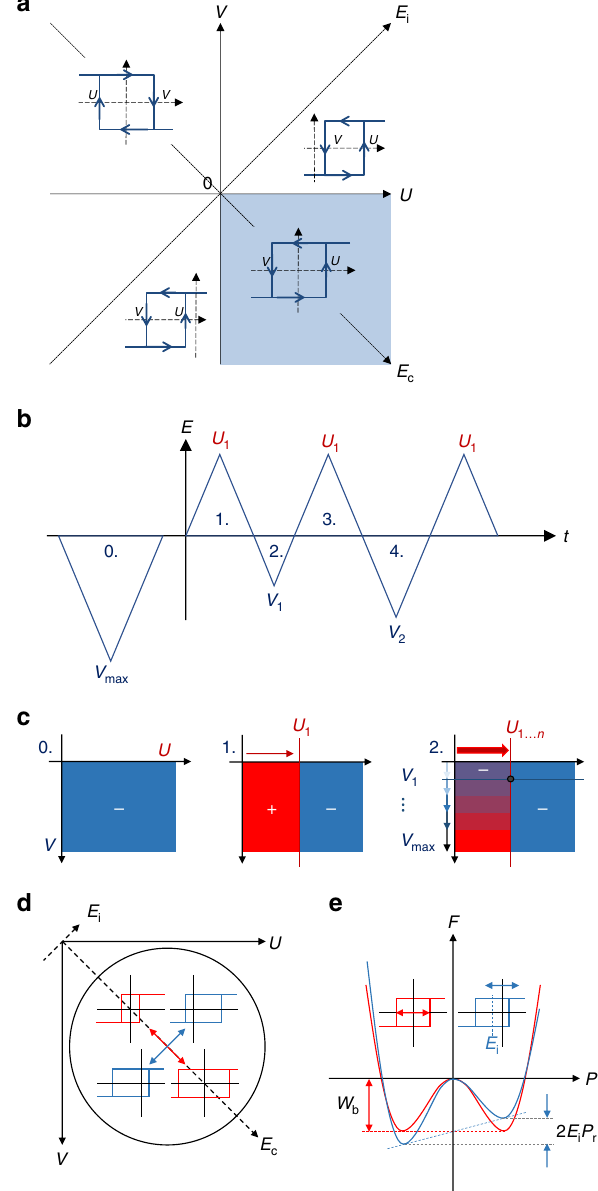
Fig. 1 Measuring the Preisach distribution. a The Preisach plane with both axes systems as explained in the main text. Four different types of hysterons are indicated, the shaded lower right area (4th quadrant) is the probed region of interest. b The pulse sequence used to measure the Preisach distribution and c the corresponding sweeps in the Preisach plane. Darker shaded areas show the part of the Preisach plane that was switched in the corresponding sweep. d Interpretation of the Preisach distribution in quadrant IV of the Preisach plane. Along the diagonal red line ( E c ) hysteresis curves are symmetric ( E i = 0) with variations in the magnitude of U = − V . These changes are caused by variation in the energy barrier for switching W b . Broadening along the perpendicular blue diagonal ( E i ) comes from local interaction fi elds that shift the hysteresis curves by an offset ± E i . e Corresponding free energy landscape (Landau plot), P r being the remnant polarization and V * the critical nucleation site